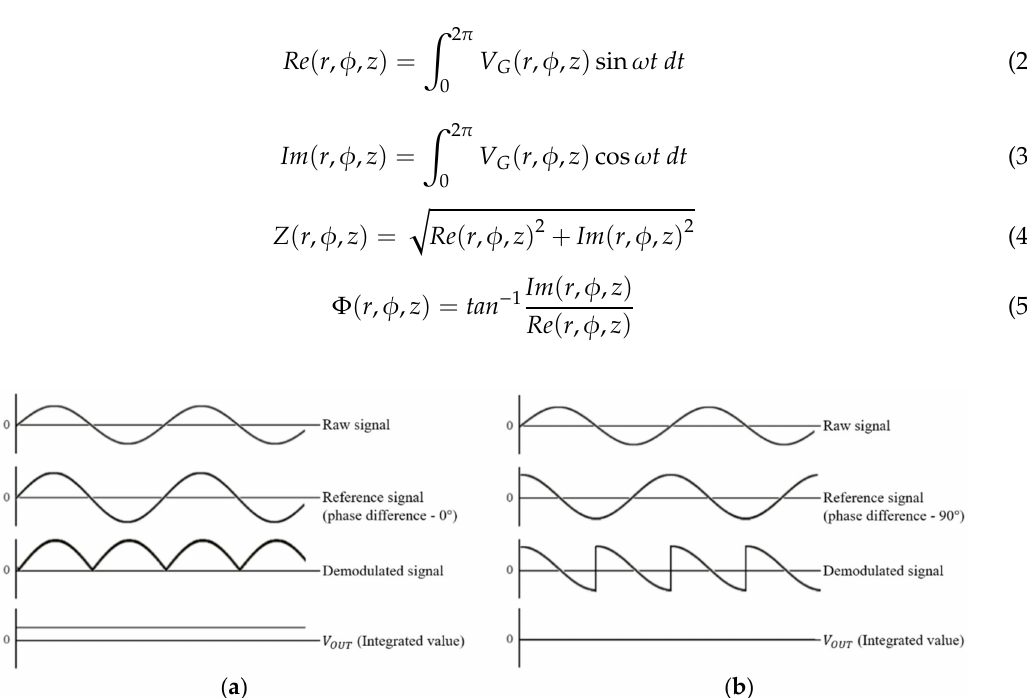
Figure 2. Real and imaginary part of the output signal calculation procedure: ( a ) real part; ( b ) imaginary